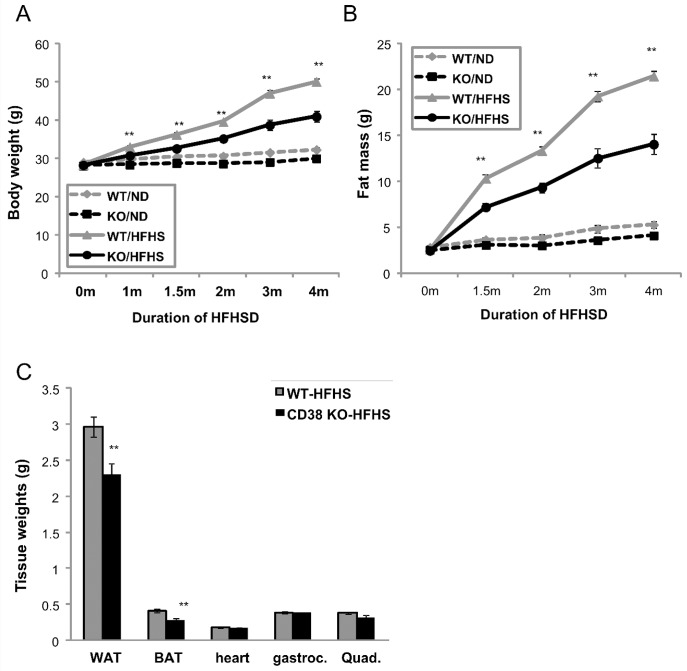
CD38 KO mice are protected from HFHSD- induced obesity.(A) Body weight was measured for WT (grey) and CD38 KO (black) during the 4 months of ND (dashed lines) or HFHSD (solid lines) treatment from age of 2months old. n = 13–15. **, p value<0.01 (WT vs KO). (B) Fat mass was measured by qNMR for WT (grey) and CD38 KO (black) during the 4 months of ND (dashed lines) or HFHSD (solid lines) treatment from age of 2months old. n = 13–15. **, p value<0.01 (WT vs KO). (C) Tissue weights were measured for WT (grey) and CD38 KO (black) after animals were dissected after 4 months of HFHSD. n = 8 **, p value<0.01 (WT vs KO).